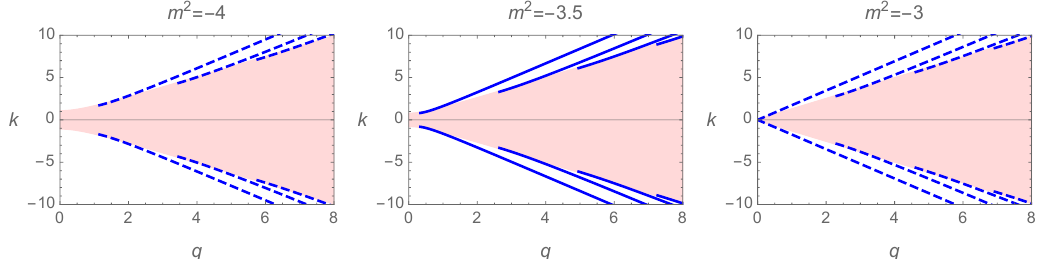
Figure 4 . Phase diagram for the alternative quantization. We take K = 1 , and the vertical axis is √ k ≡ λ − 1 . The region with IR instability is shaded.